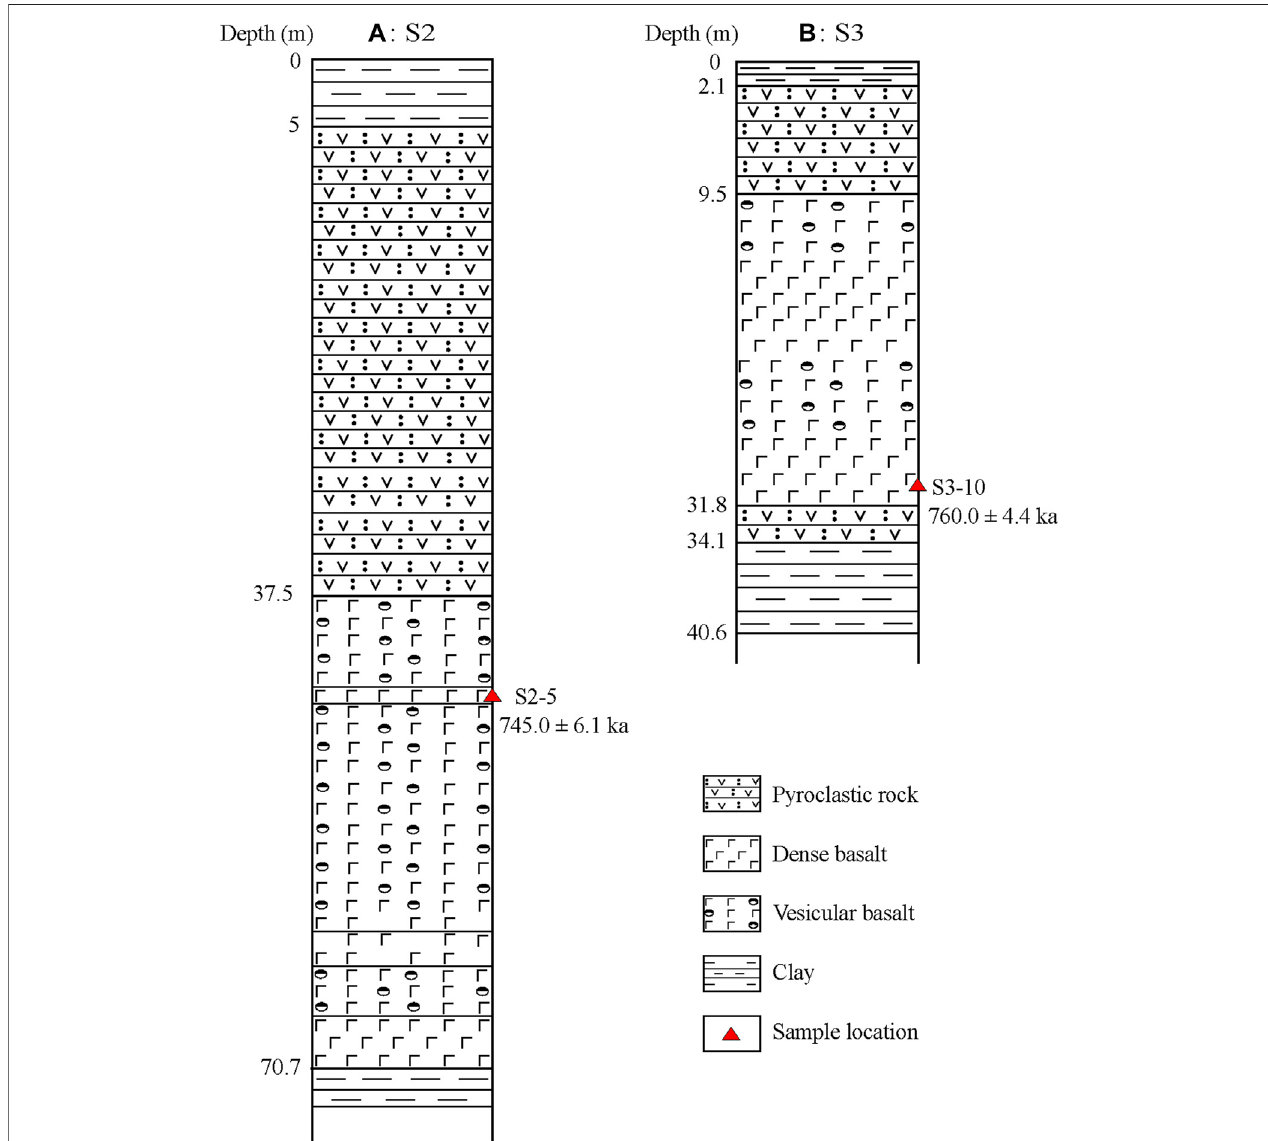
FIGURE 9 | Stratigraphic columns boreholes. (A) S2 borehole. (B) S3 borehole.